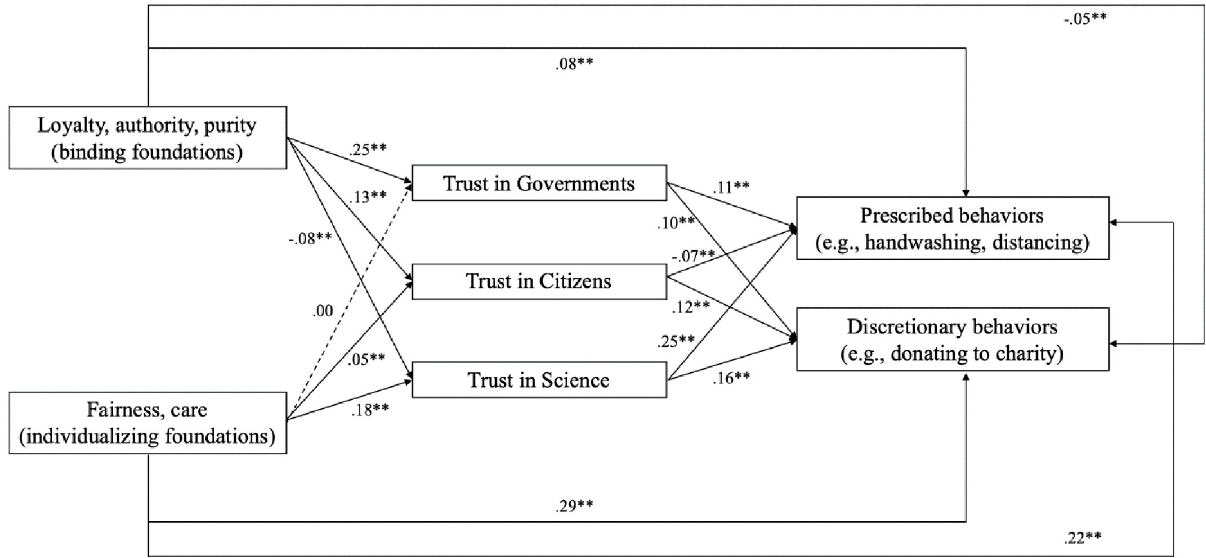
Fig 4. Multivariate multi-level regression model in which individualizing moral foundations (fairness and care) and binding moral foundations (loyalty and authority) were modelled as independent variables, prescribed and discretionary COVID-19 related behaviors as dependent variables, and trust in governments, trust in citizens, and trust in science as parallel mediators. �� p <